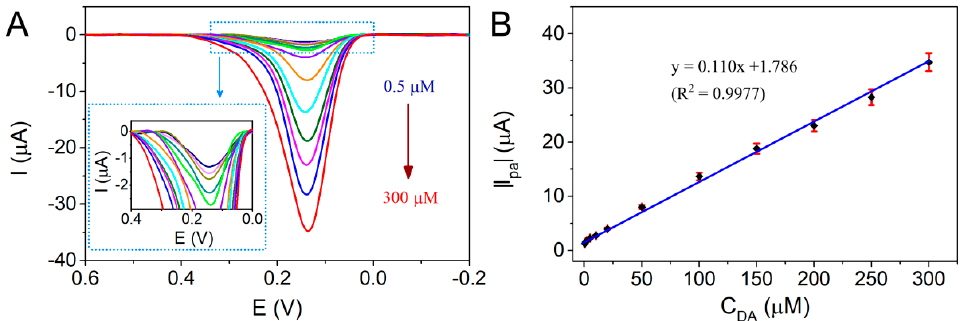
Figure 4. ( A ) The DPV curves of MoS 2 / Au / CPE in 0.1M PBS solution (pH 7.0) containing DA with a series of concentrations (0.5, 1, 2, 5, 10, 20, 50, 100, 150, 200, 250, and 300 µ M) and ( B ) the relationship of I pa value versus the concentration of DA. Table 1. Comparison of electroanalytical performances of different modified electrodes for DA detection.